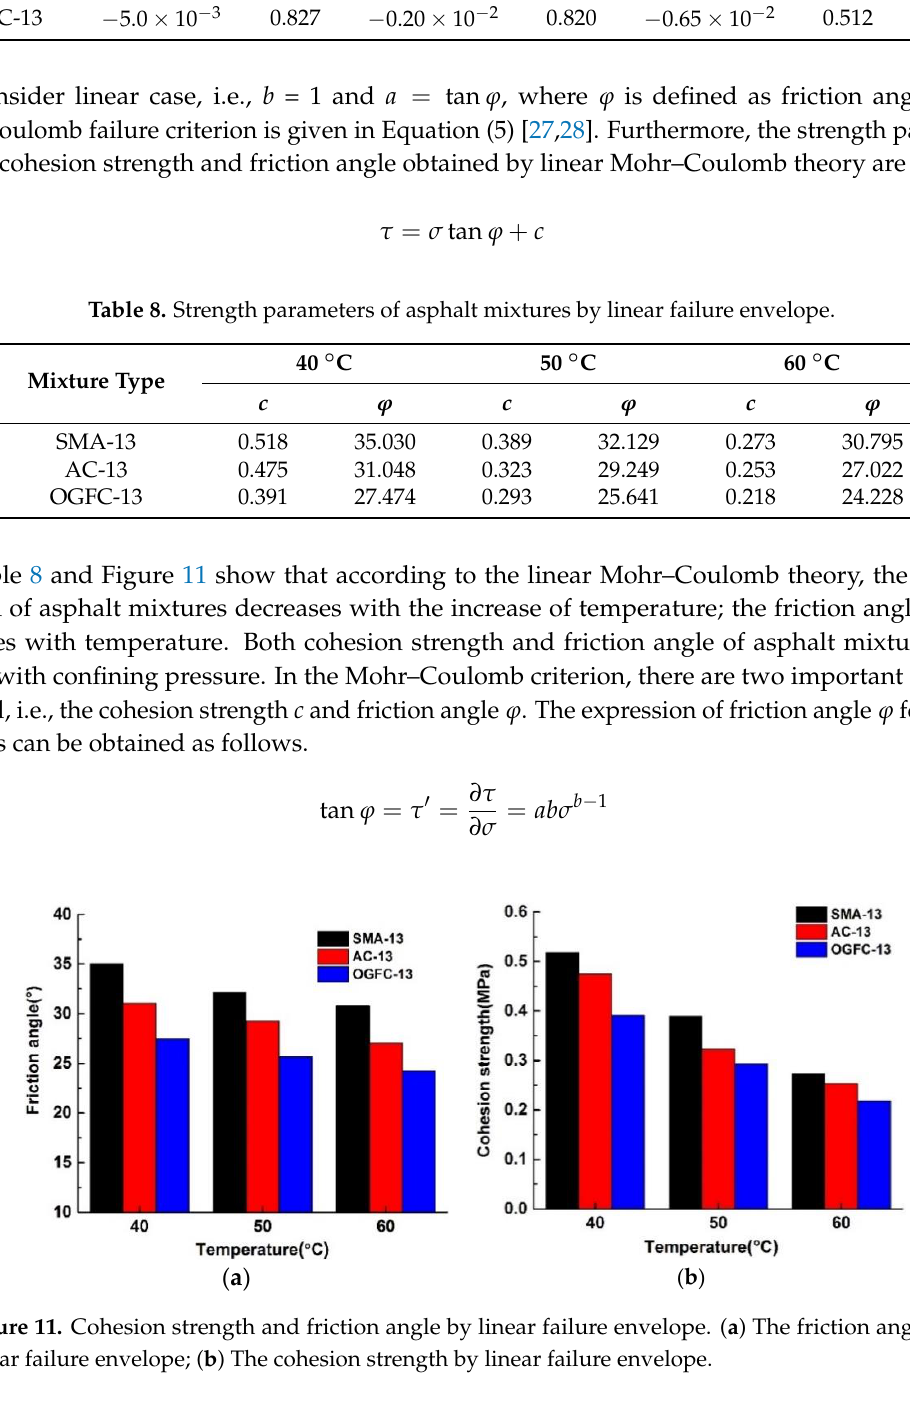
Table 7. Parameters of the σ − τ model considering the influence of temperature and confining pressure.